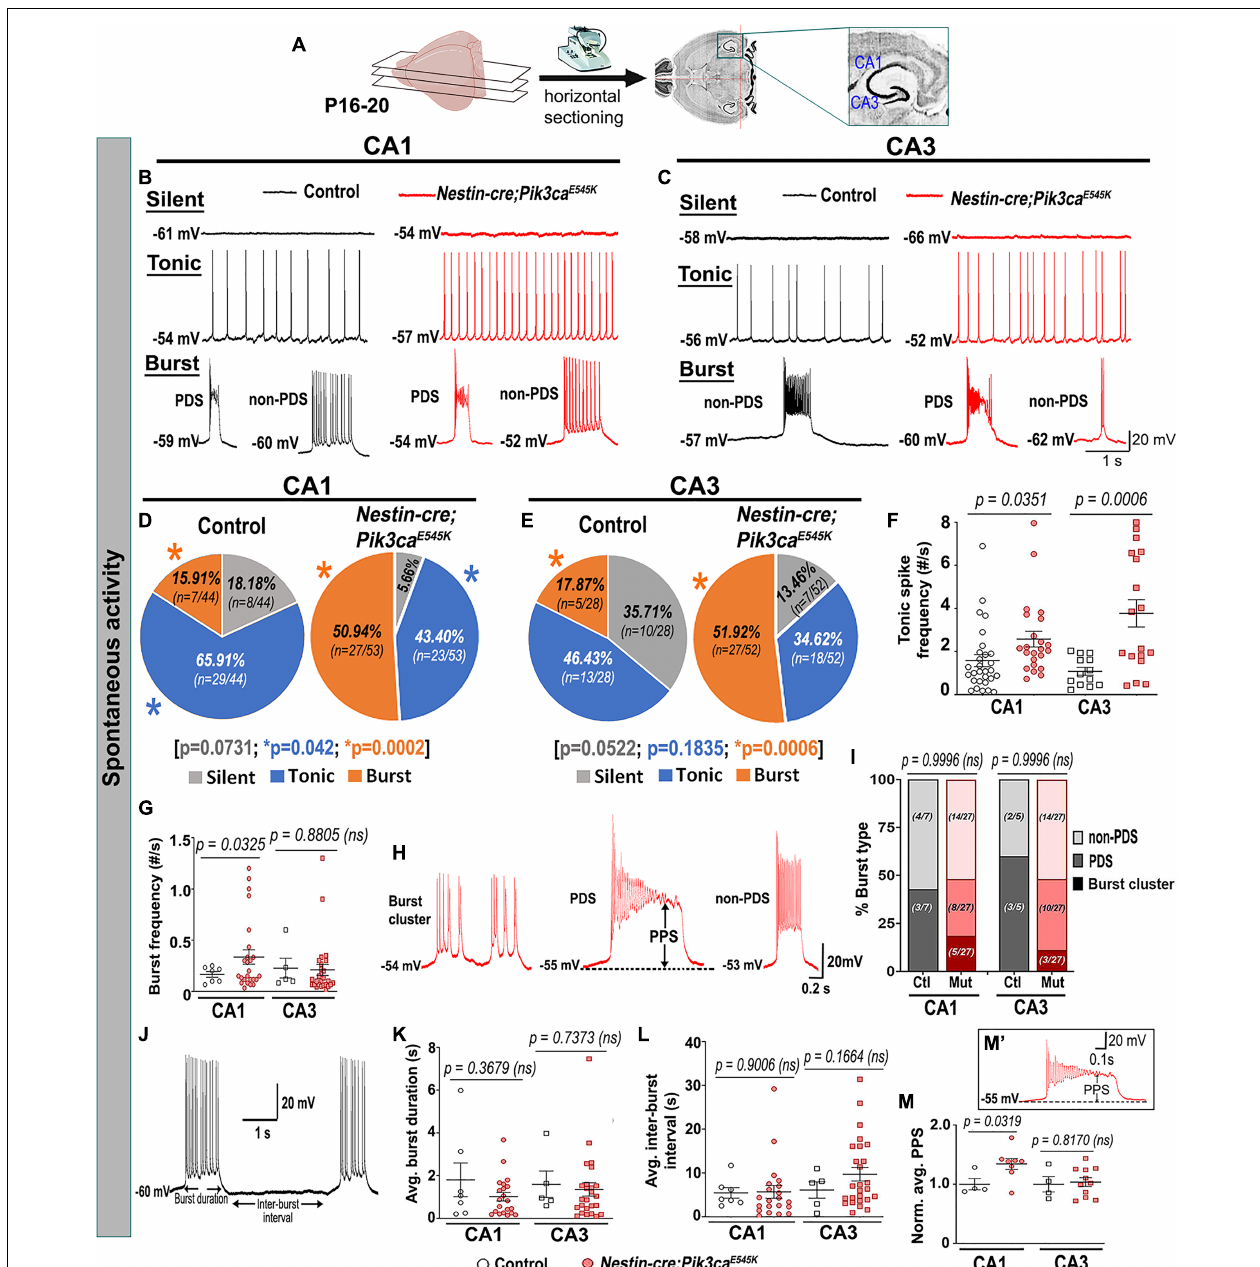
FIGURE 2 | Mutant hippocampal neurons produce increased epileptiform burst activity. (A) Flowchart shows acute horizontal brain slicing for whole-cell recording. (B–E) Traces represent silent, tonic, and burst categories of CA1 and CA3 neurons based on spontaneous cellular activity; respective pie charts marked proportion of recorded cells. Mutant CA1 and CA3 exhibited significantly higher proportions of burst-firing cells compared to controls. Significantly fewer tonic-firing cells were observed in mutant CA1. (F,G) Relative to controls, spontaneous tonic spike frequencies were significantly higher in mutant CA1 ( t = 2.175, df = 43.71) and CA3 ( t = 4.063, df = 19.78) cells; burst frequency was significantly higher in mutant CA1 (CA1: t = 2.244, df = 29.38; CA3: t = 0.1561, df = 6.754). (H) Representative traces for subtypes of burst firing, namely burst cluster, paroxysmal depolarization shift (PDS) and non-PDS plateau bursts. (I) Proportion of burst subcategories were not overtly different in control and mutant CA1 and CA3 regions ( F = 7.355e - 12 ; df = 6); burst clusters were only seen in mutant cells. (J) Representative trace demonstrates how burst duration and inter-burst interval were calculated. (K,L) In both CA1 and CA3, average (avg.) burst duration (CA1: t = 0.9644, df = 6.793; CA3: t = 0.3508, df = 6.229) and inter-burst interval (CA1: t = 0.1263, df = 22.31; CA3: t = 1.485, df = 10.73) were not significantly different between control and mutant neurons. (M’) Plateau potential shift (PPS) in mutant bursting cells, as depicted in panel (M’) , was significantly higher in CA1 ( t = 2.586, df = 8.118) but similar in CA3 ( t = 0.2436, df = 5.110), compared to respective controls. Data is represented as pie charts, % bar graphs and mean ± SEM scatter plots; differences were considered significant at p < 0.05; ns, not significant; PPS, plateau potential shift. Scale bars: 1 s, 20 mV (B,C,J) ; 0.2 s, 20 mV (H) ; 0.1 s, 20 mV (M’) .